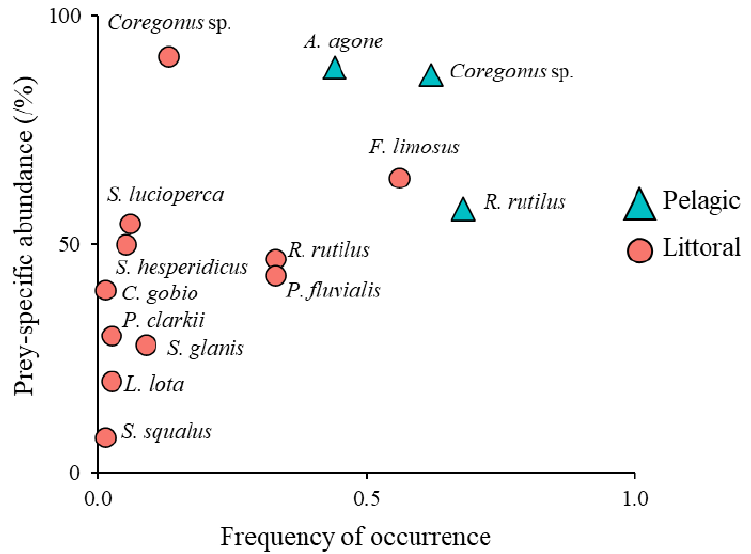
Figure 5. Feeding strategy plot (modified Costello graph; [56,57]) of pelagic and littoral catfish diet displaying the frequency of occurrence and prey-specific abundance of each prey (circles = prey item of littoral catfish; triangles = prey items of pelagic catfish).